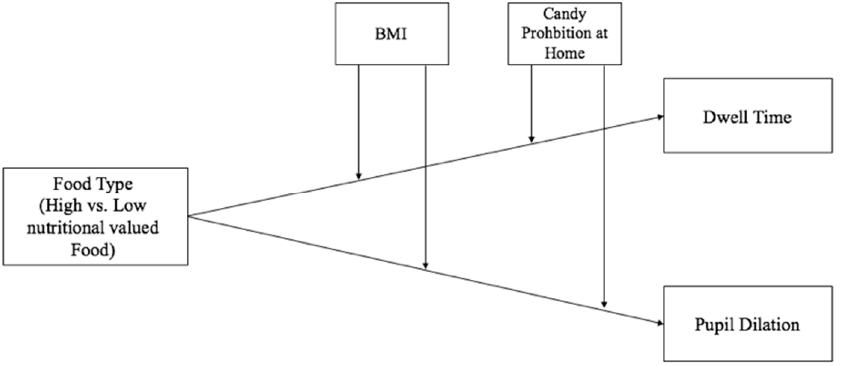
Figure 1. Conceptual